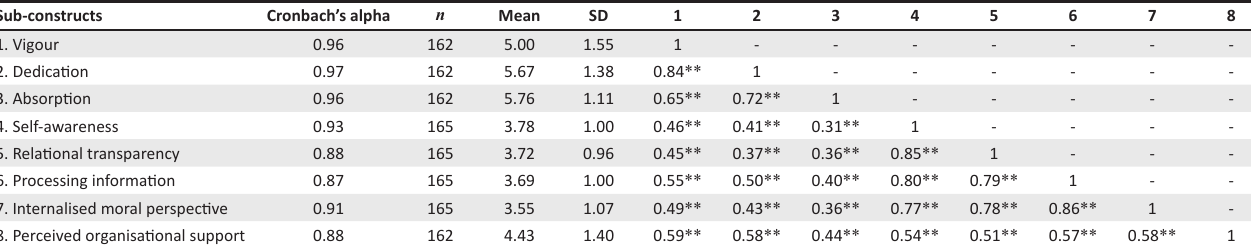
TABLE 3: Descriptive statistics, correlations and scale reliabilities for sub-constructs. Sub-constructs